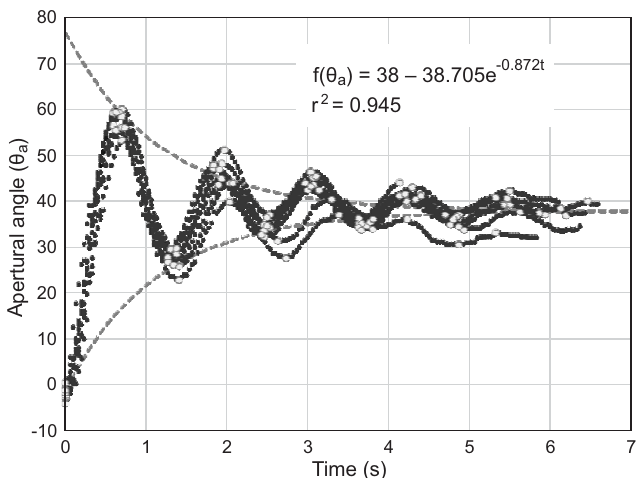
Fig. 8. Hydrodynamic restoration of the Nautilus pompilius 3D printed model following underdamped harmonic oscillation. Apertural angle ( θ a ) measured in degrees as a function of time after rotating approximately 38° from the equilibrium orientation. An angle of zero represents a condition where the aperture is horizontally oriented. Open dots represent the peaks used to calculate decay in amplitude with time (grey dashed